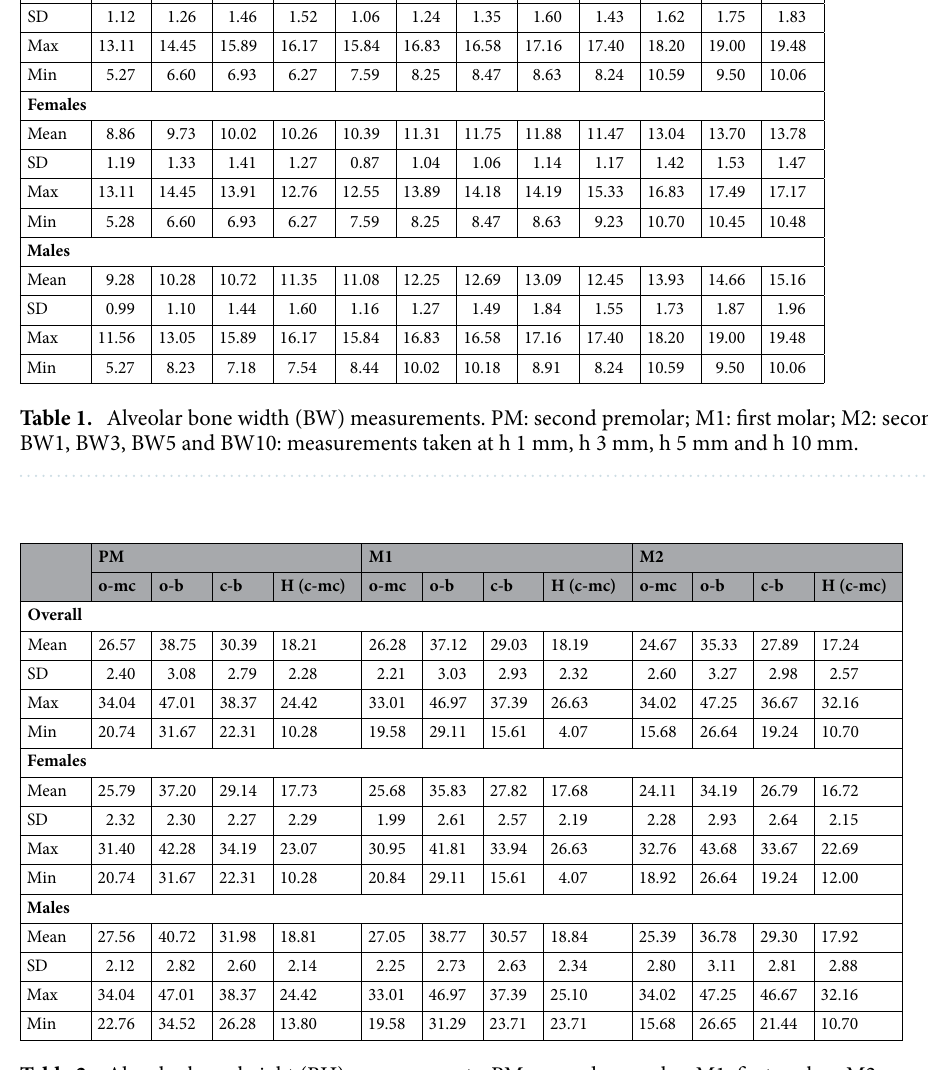
Table 2. Alveolar bone height (BH) measurements. PM: second premolar; M1: first molar ; M2: second molar; o-mc: distance between the occlusal plane and the most coronal point of the mandibular canal; o-b: distance between the occlusal plane and the basal bone; c-b: distance between the crest and the basal bone; H (c-mc) distance between the crest and the mandibular